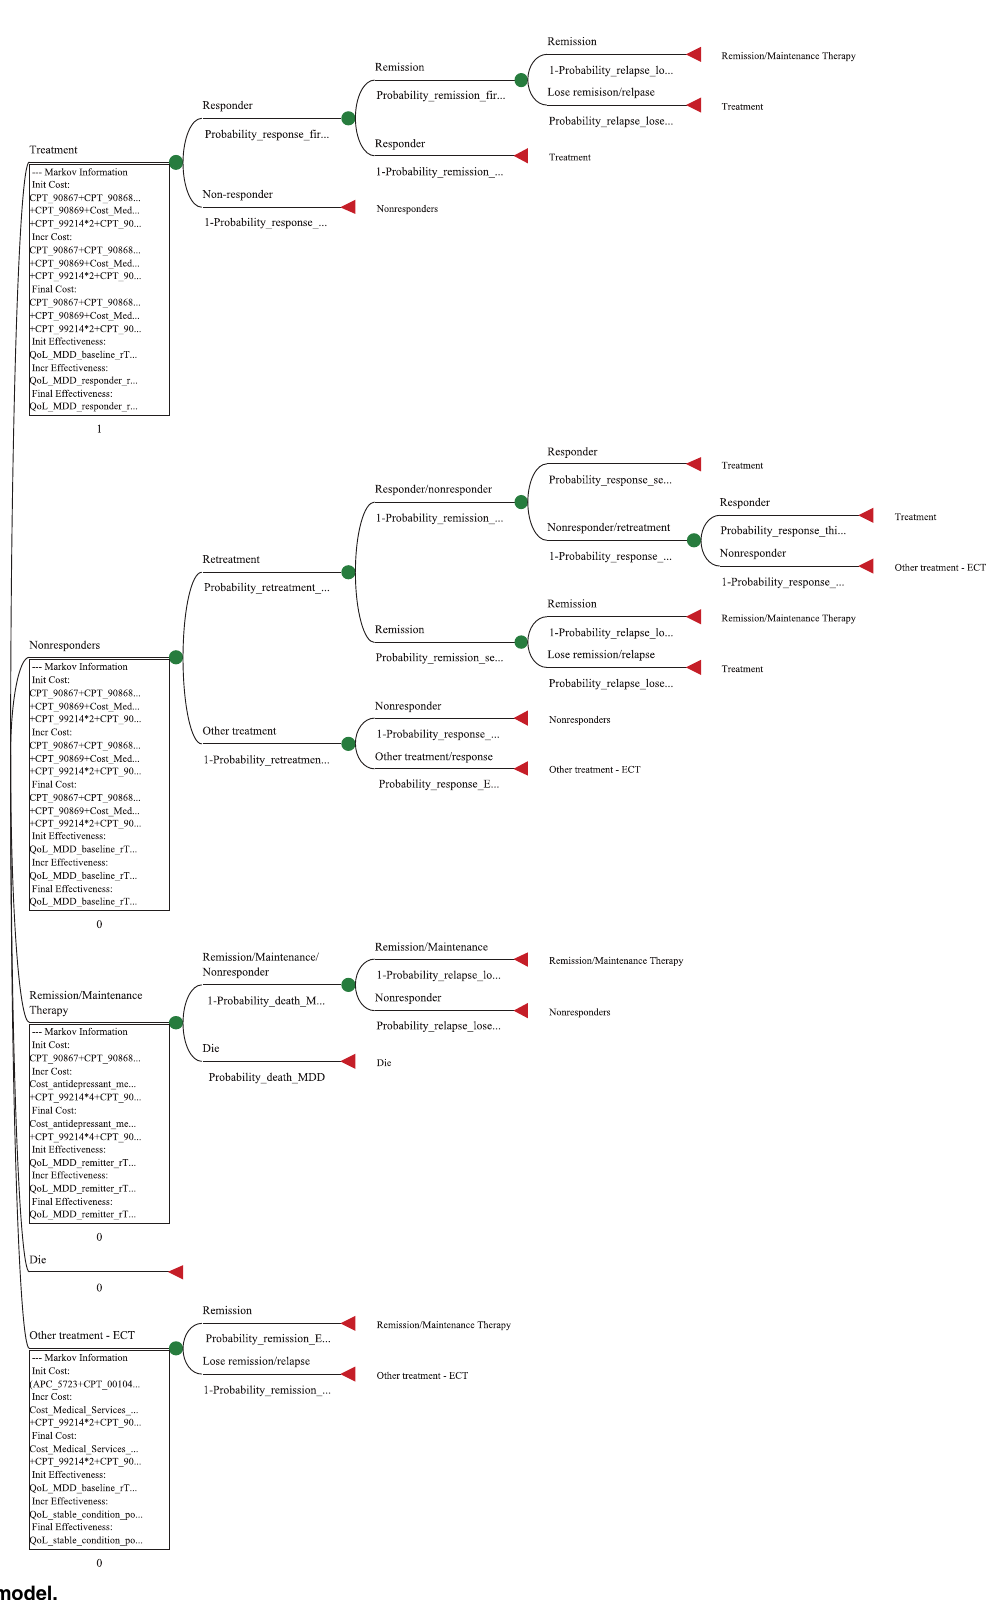
PLOS ONE | https://doi.org/10.1371/journal.pone.0186950 October 26,